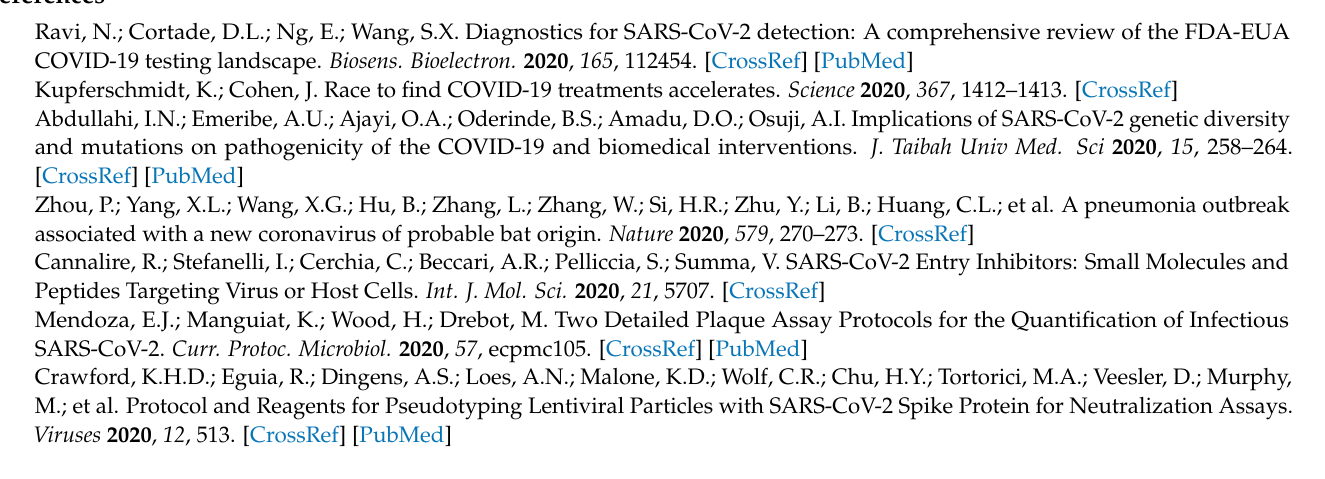
Table S2, Primers used for deletions and